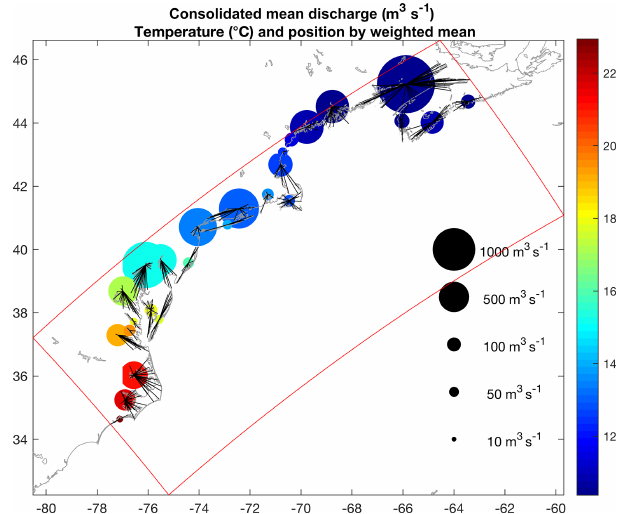
Figure 3. River model aggregations. Point size indicates discharge volume; color indicates mean temperature in Celsius. Line seg- ments link individual rivers to their discharge-weighted mean lo- cation and illustrate the effective watershed extent. Red perimeter denotes Doppio domain